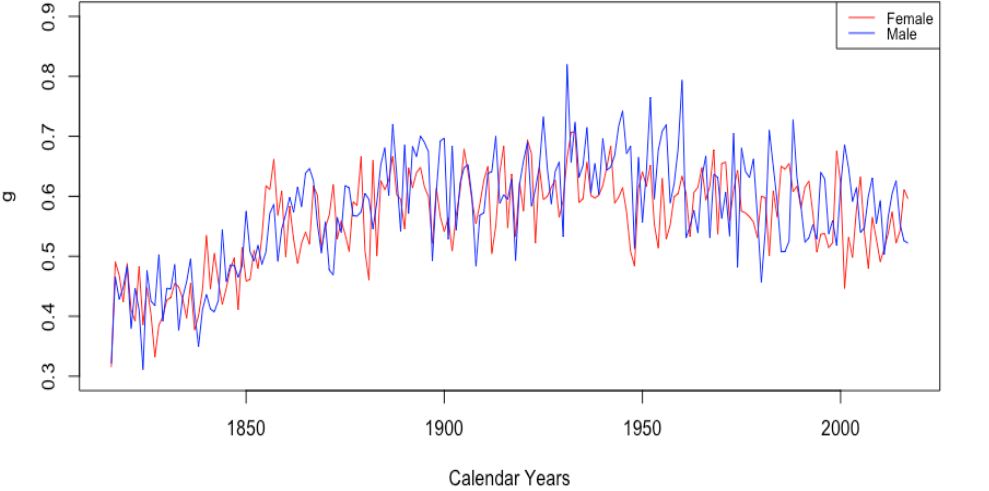
Figure 10. Limiting old age mortality g for France civilian females during 1816 to 2018. Mortality acceleration factor b ( x ) with parameters M 2 , β 1 , β 2 , β